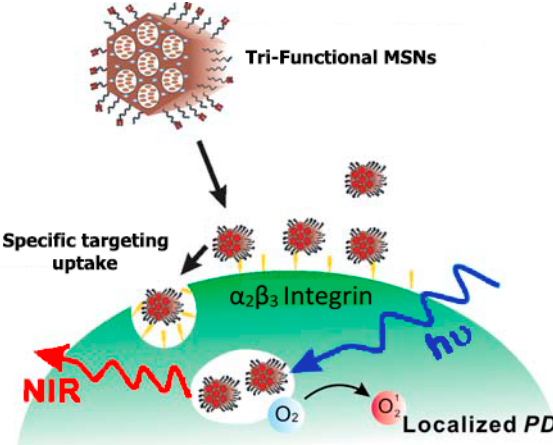
Figure 3. Synthesis of the tri-functionalized mesoporous silica nanomaterial (MSN), A647@MSN-RGD-PdTPP. The nanomaterials were initially functionalized with ATTO 647N, then photodynamic therapy photosensitizer (PS) agent (APTMS-PdTPP), and lastly with the tumor targeting ligand (cRGD). Reproduced from Reference [58] with permission from The Royal Society of Chemistry.